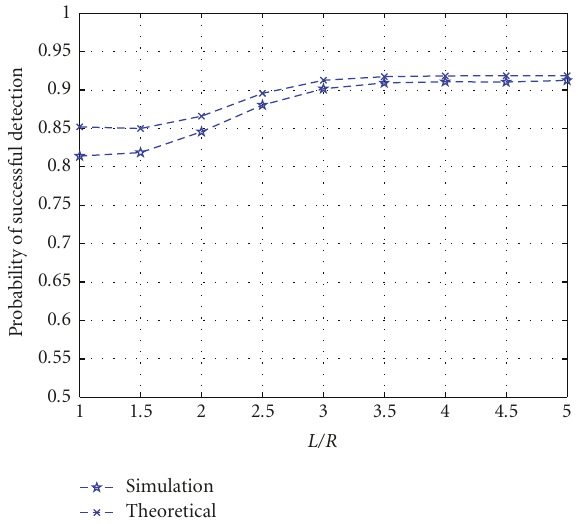
Figure 9: Probability of successfully identifying all V -locators: Simulation versus